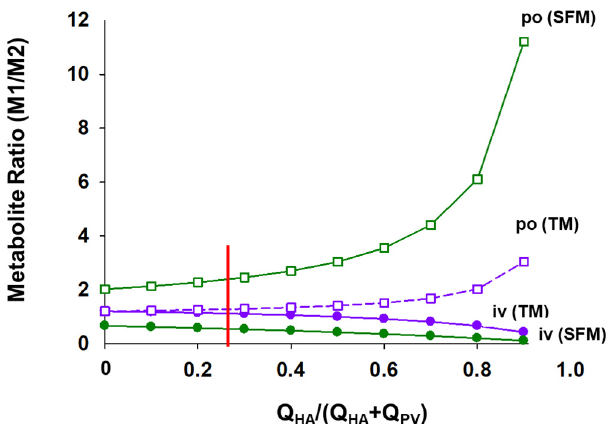
Figure 5. Formation of M1 and M2, specific metabolites formed by the intestine and liver, respecitvely, as simulated by Noh and Pang [18]. The hepatic arterial flow (Q HA ), normally 25% of total liver blood flow (shown where red line is), delivers the drug directly into the liver, and this contributes M2 formation. Additionally, M2 formation is highest according to the SFM for iv drug administration wherein M1 formation is low due to the low f Q . For the TM, the extent of M2 formation is identical for a drug given orally and intravenously, when there is no Q HA flow; the extent increases with increasing Q HA . This figure was reproduced with permission from Noh and Pang [18], Wiley, 2019.